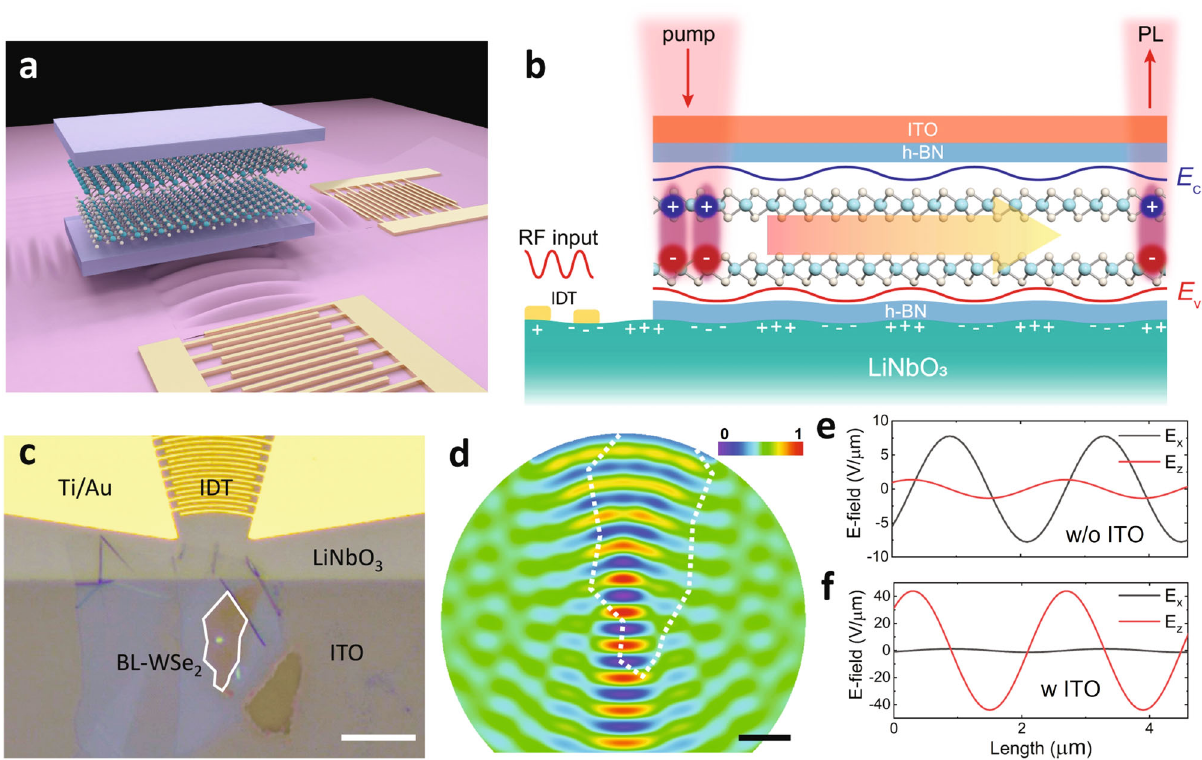
Fig. 1 Bilayer WSe 2 integrated with SAW devices. a Schematic illustration of the h-BN encapsulated bilayer WSe 2 stacked on SAW devices. The IDTs generate SAW to transport the excitons in different directions. b The propagating SAW modulates the energy of the excitons and transports them from the pump spot to the fl ake edge, where they recombine to generate photoluminescence. For simplicity, we only plot + z interlayer exciton in bilayer WSe 2 . See S.I. for details. c Optical microscope image of the device, with the white line outlining the bilayer WSe 2 . Scale bar, 20 µ m. d The piezoelectric fi eld pro fi le of the SAW generated by the focusing IDT. The acoustic focal point has a waist of 3 µ m and is at the edge of the bilayer WSe 2 . The dotted line outlines the WSe 2 fl ake. Scale bar, 5 µ m. e , f The piezoelectric fi eld distribution with ( e ) and without ( f ) the top ITO electrode. The fi eld amplitude is calculated assuming an acoustic power density of 1 mW/ µ m. The ITO electrode can ef fi ciently suppress the in-plane piezoelectric fi eld component ( E x ), which causes undesirable exciton